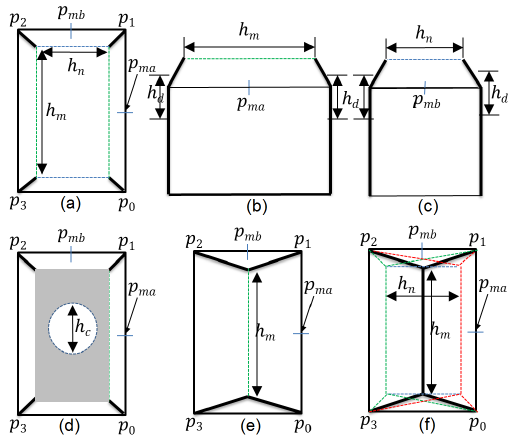
Figure 4: Top row (a), (b) and (c): Illustration of mansard roof parametrization. Bottom row: In (d) the gray region illustrates the actual search space for the mansard roof excluding pinnacle roof candidates. (e) and (f) illustrate the symmetric and asym- metric (half)-hipped roof parametrization